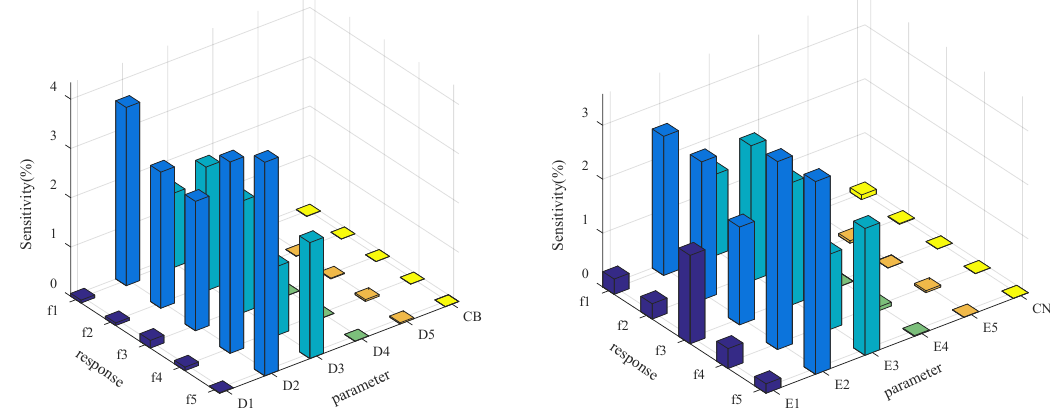
Figure 18. Histogram of parameter sensitivity analysis.